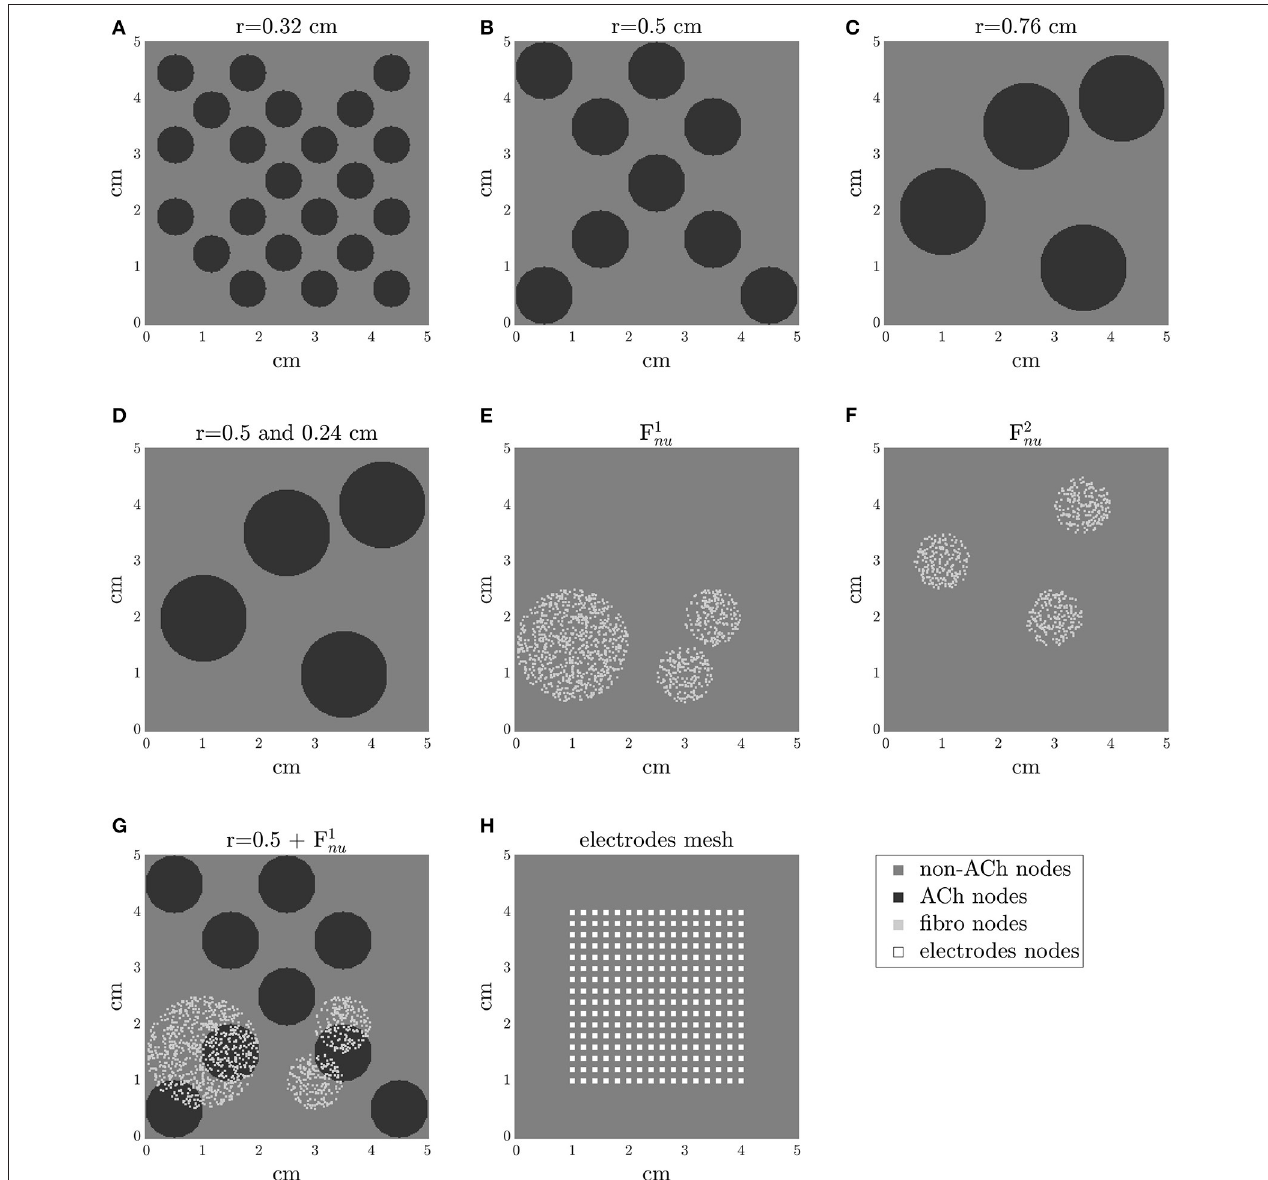
FIGURE 1 | 2D tissue models with different distributions of ACh release sites in (A–D) and with different fibrosis distributions in (E,F) . In (G) , an example of a tissue model with ACh release sites and non-uniform diffuse fibrosis (Fnu). In (H) , the mesh of electrodes is represented. Electrode size is adapted for clarity.